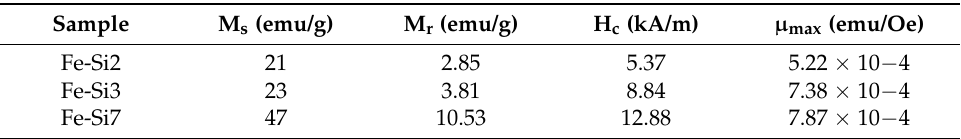
Table 3. Magnetic parameters (saturation magnetization, retentivity, coercivity, and maximum permeability) of the raw powders.